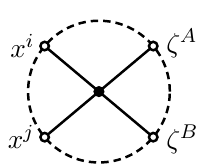
Figure 6 . Connected contribution to h x i x j Y A Y B i . The 4-vertex comes from the quartic La- grangian (2.8).